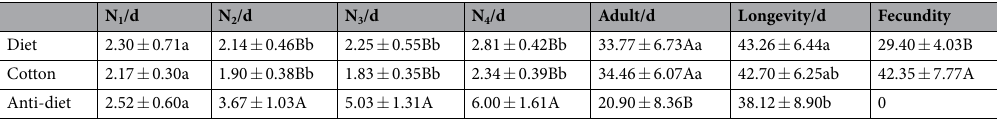
Table 2. Effects of artificial diets and antibiotic treatment on the development and fecundity of A. gossypii (F 17 ). Data are mean ± SE. Different lowercase and uppercase letters within the same column indicate significant difference at 5% and 1% levels by using LSD multiple comparison method. Diet: Artificial diet; Anti-diet: Diet containing